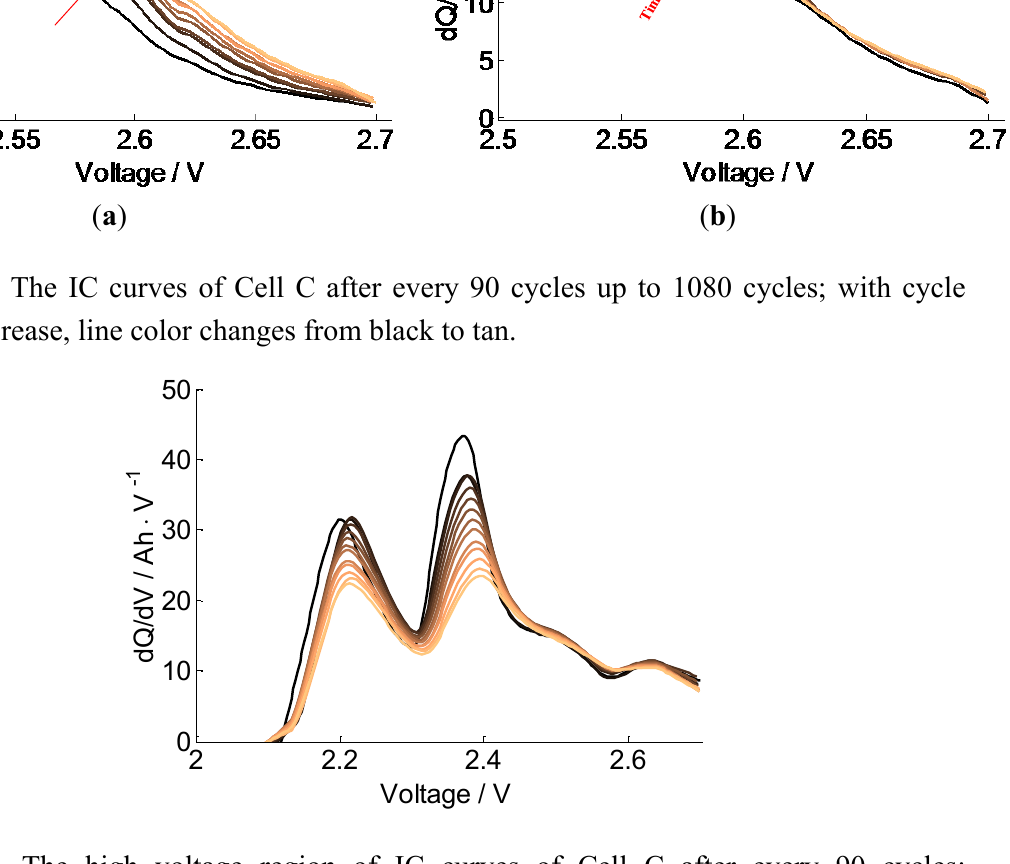
Figure 13. The high voltage region of IC curves of Cell C after every 90 cycles: ( a ) after 0 cycles up to 810 cycles; and ( b ) after 810 cycles up to 1080